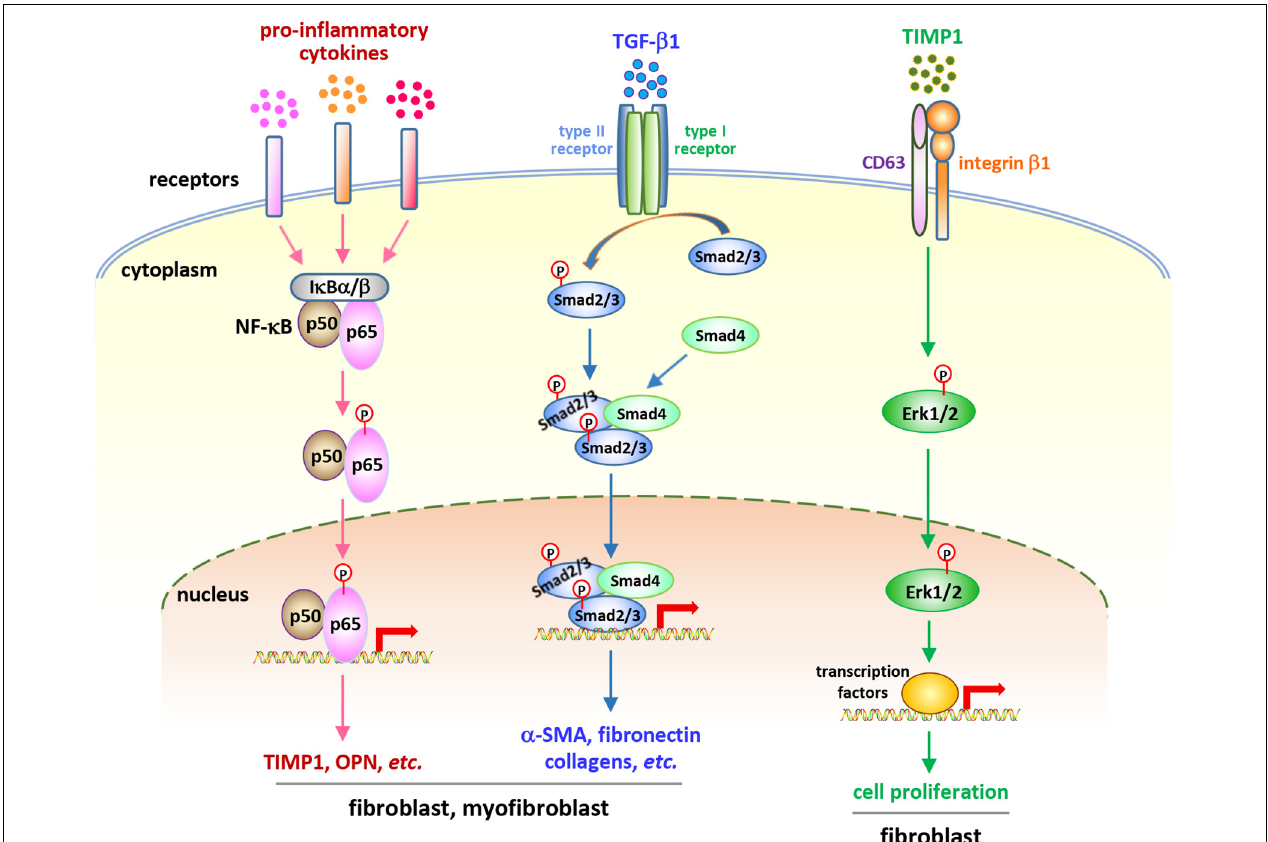
FIGURE 2 | Soluble factor-activated signaling pathways in fibroblastic cells in CNT-exposed mouse lungs. Certain pro-inflammatory and pro-fibrotic mediator-regulated signaling pathways, including the canonical NF- κ B pathway, the canonical, Smad-dependent TGF- β pathway, and the ERK signaling, have been reported to be activated in fibroblastic cells in CNT-exposed lungs. These pathways exert crucial functions in promoting the development of fibrosis induced by CNTs. They demonstrate the activities and roles of fibroblasts and myofibroblasts, as well as the connections between immune factors and fibrosis development, in the lung under CNT